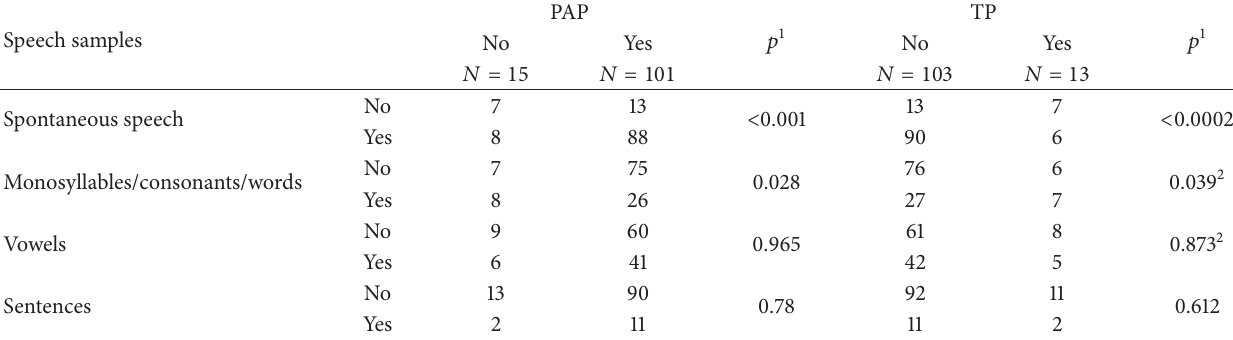
Table 5: Speech samples and palatal augmentation prosthesis (PAP) or tongue prosthesis